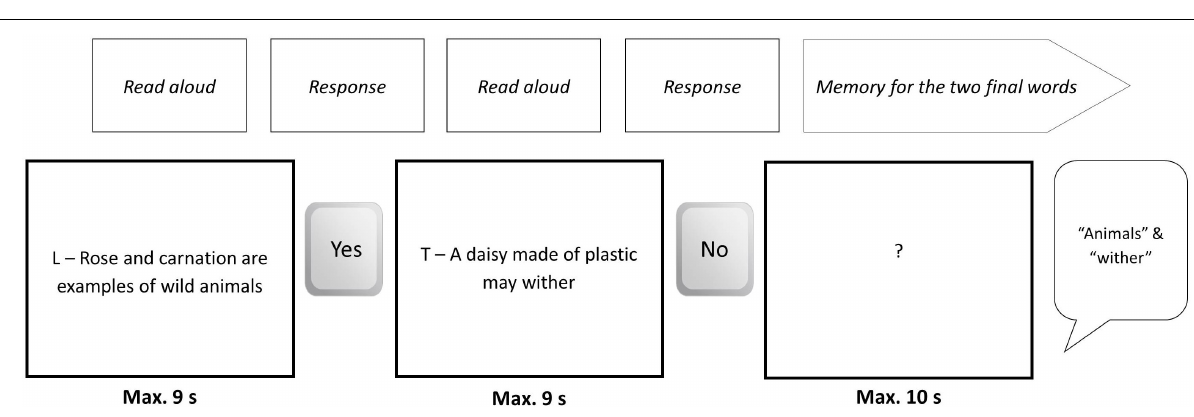
FIGURE 2 | Example of a series of events for a block from Level